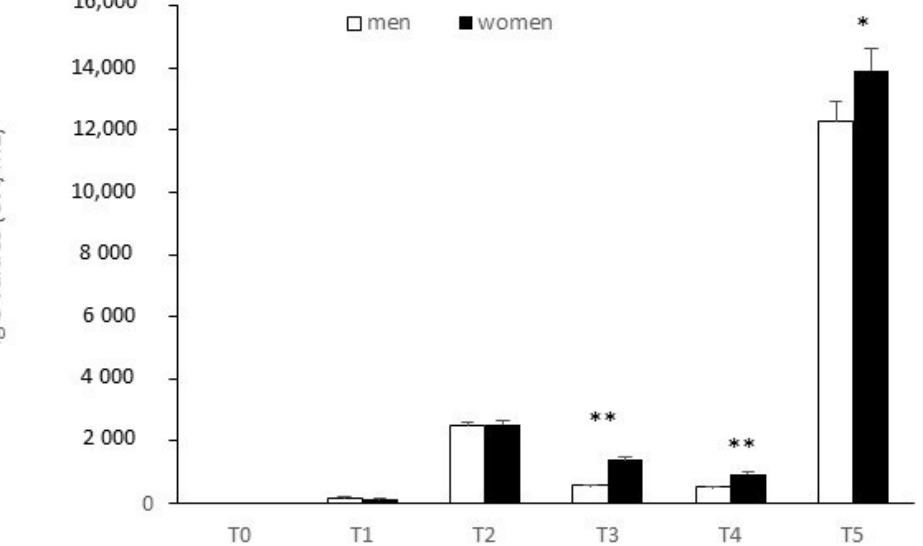
Figure 2. The serum IgG levels in the enrolled response to vaccine (IgG > 50 AU/mL) in men and women. Data are expressed as the mean ± standard deviation at different follow-up (T0: admission, I dose of vaccine; T1: II dose of vaccine: 3 weeks after T0; T2: 2 months after T1; T3: 3 months after T2; T4: 6 months after T1, in this time, the patients underwent the III dose of vaccine; T5: 3 weeks after T4, end of the study). * p < 0.05; ** p < 0.01.